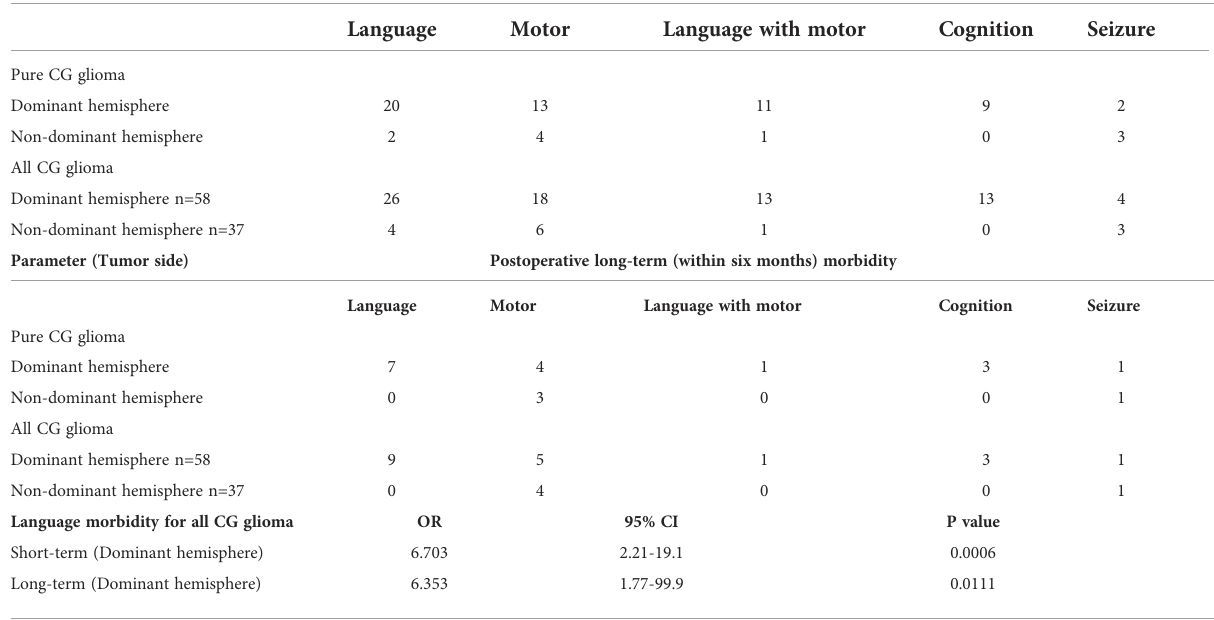
TABLE 5 Summary of relationship between function de fi cits and dominant